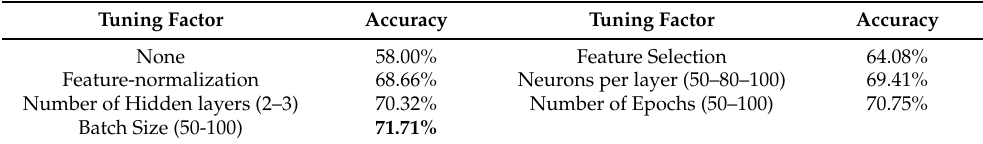
Table 4. The effect of parameter tuning on the accuracy of DNN-TL model. The parameter tuning gave an absolute gain of 13.71% over the baseline model. The best accuracy is shown in